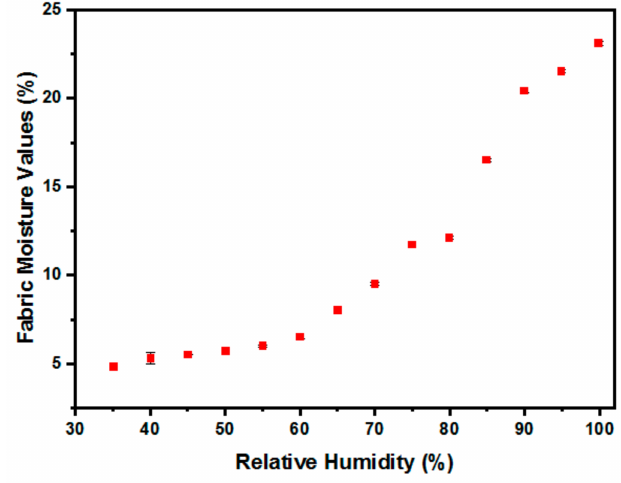
Figure 6. Graph of fabric moisture change against relative